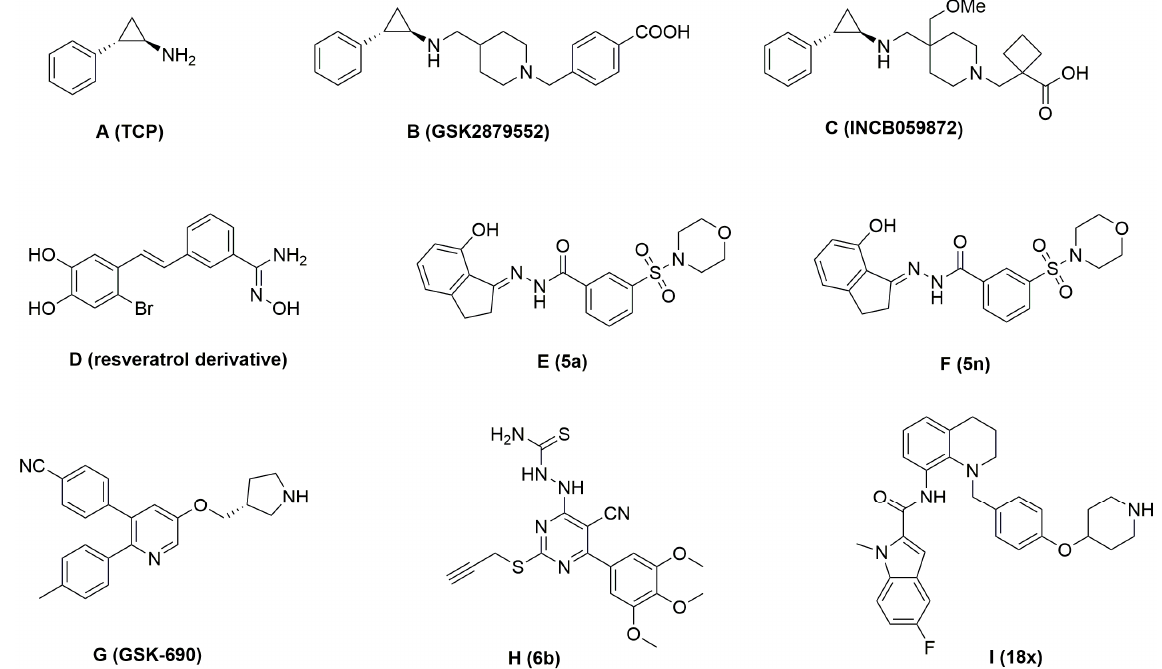
Figure 1. S tructures of several reported LSD1 inhibitors. Figure 1. Structures of several reported LSD1